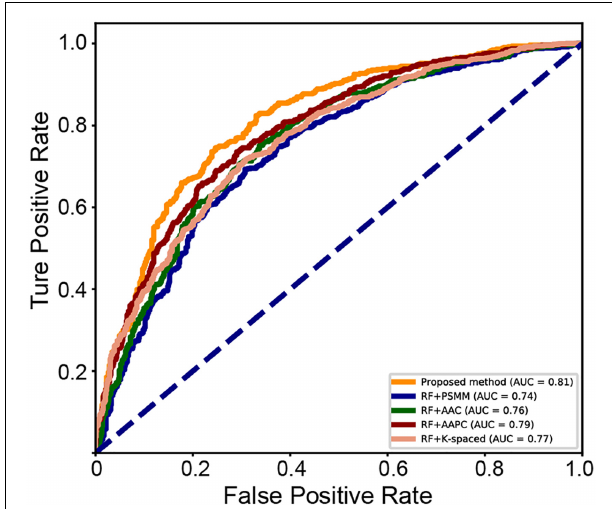
FIGURE 8 | ROC curve of the different methods on the testing